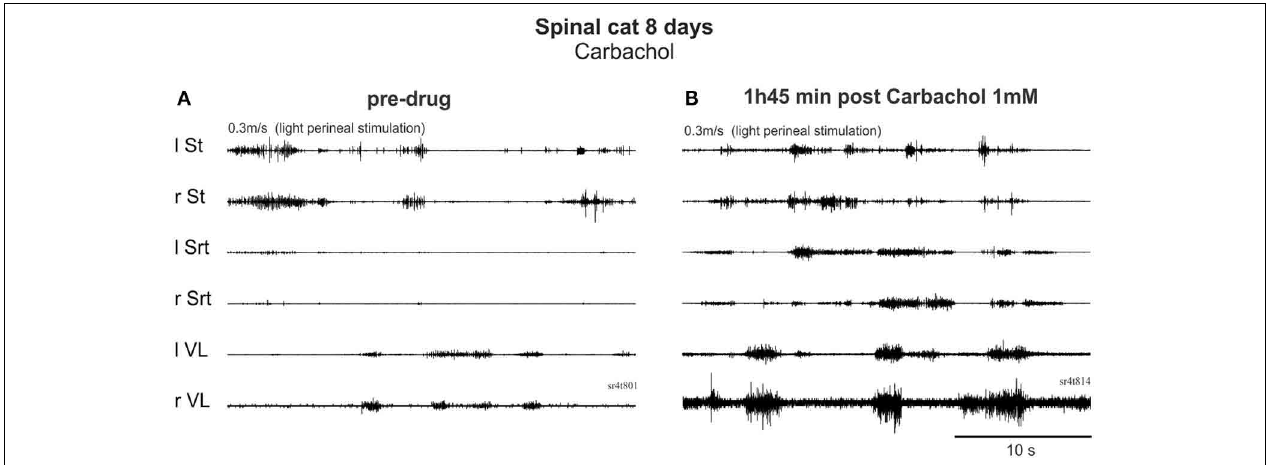
FIGURE 7 | Carbachol, a cholinergic agonist, produced co-contractions and interfered with locomotor activity early after injury. (A) Pre-drug trial with EMG activity produced by perineal